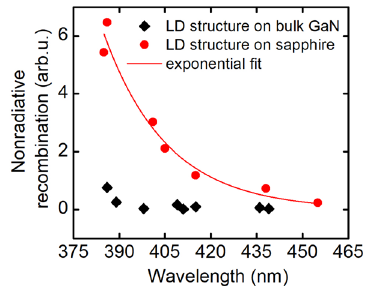
Figure 4. Nonradiative recombination as a function of emission wavelength for laser diode structures grown on bulk GaN and sapphire.